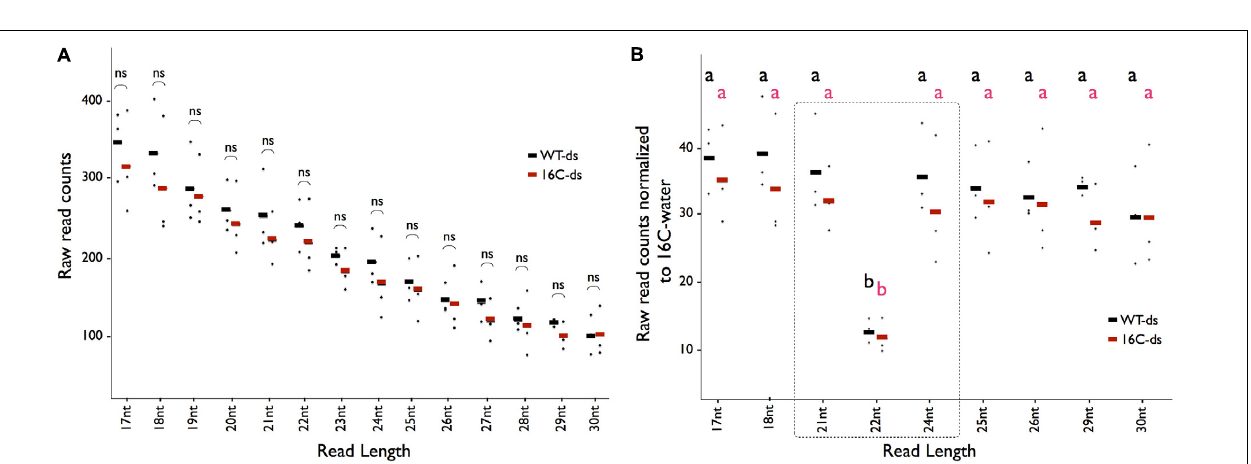
FIGURE 1 | UV-light monitoring of GFP expression after dsRNA and siRNA spraying. Nb-16C plants were sprayed with 20 ng/ µ l dsRNA-midGFP, 240 ng/ µ l dsRNA-midGFP, 240 ng/ µ l dsRNA-GFP5 (cid:48) , 1.4 ng/ µ l siRNA#164, 14 ng/ µ l siRNA#164, water only and Nb-WT plants were sprayed with 20 ng/ µ l dsRNA-midGFP. One to four leaves per plant were sprayed. The three rows show adaxial and abaxial sides of matching leaves, and close up views of abaxial sides, visualized under the UV light, respectively. The area shown in close-up view is shown in yellow rectangle in abaxial view. Nb-WT sample is completely red due to the chloroplasts and Nb-16C samples are green due to the presence of GFP. Only the positive control leaves sprayed with low and high concentration of siRNA#164 showed silencing spots, highlighted with yellow stars in the close-up view. The number of plants showing silencing over the total number of plants treated in given condition is given in parenthesis.